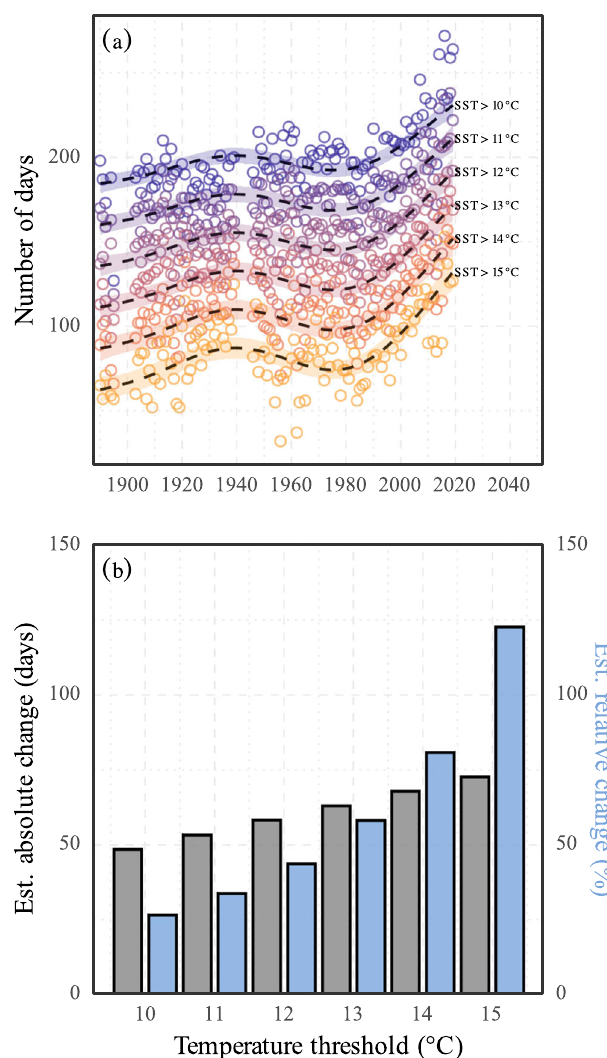
Fig. 4 Estimates of yearly calci fi cation window lengths over the last century. a Historical trends of estimated calci fi cation window length per year expressed as the number of days in which the sea surface temperature exceeds a selected threshold. 95% con fi dence intervals (shaded area) are reported for each predictor (dashed lines). b Absolute and relative change in days exceeding temperature threshold between 1890 and